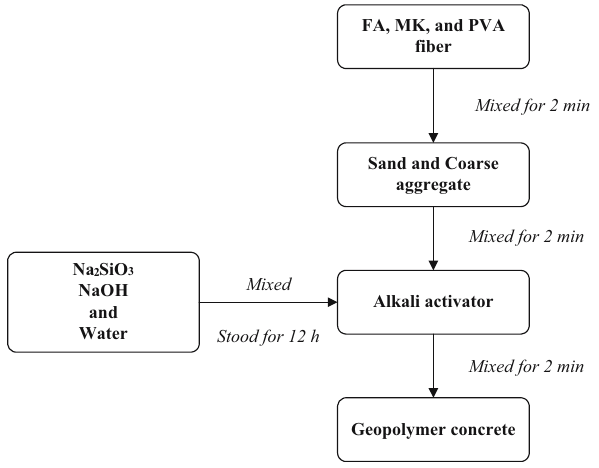
Figure 1: Preparation process of